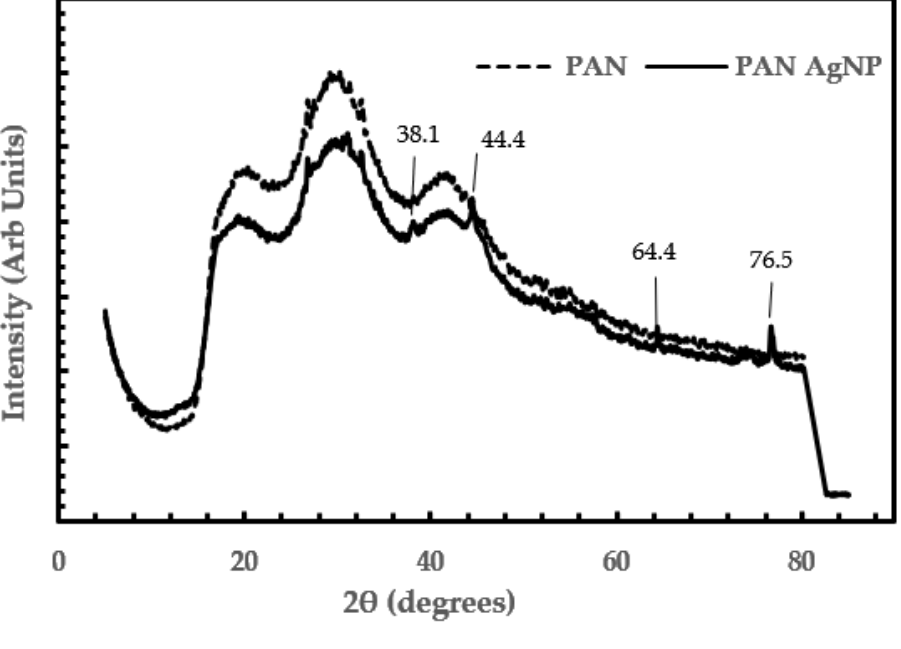
Figure 5. XRD plots of PAN and PAN–AgNP.